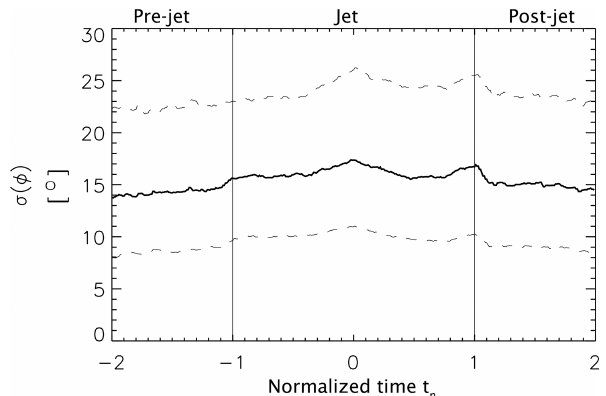
Figure 9. Superposed epoch analysis of the inter-quartile range of angles φ B , V within 10s wide time intervals, centered around re- spective normalized times. Solid line depicts the median; dashed lines depict upper and lower